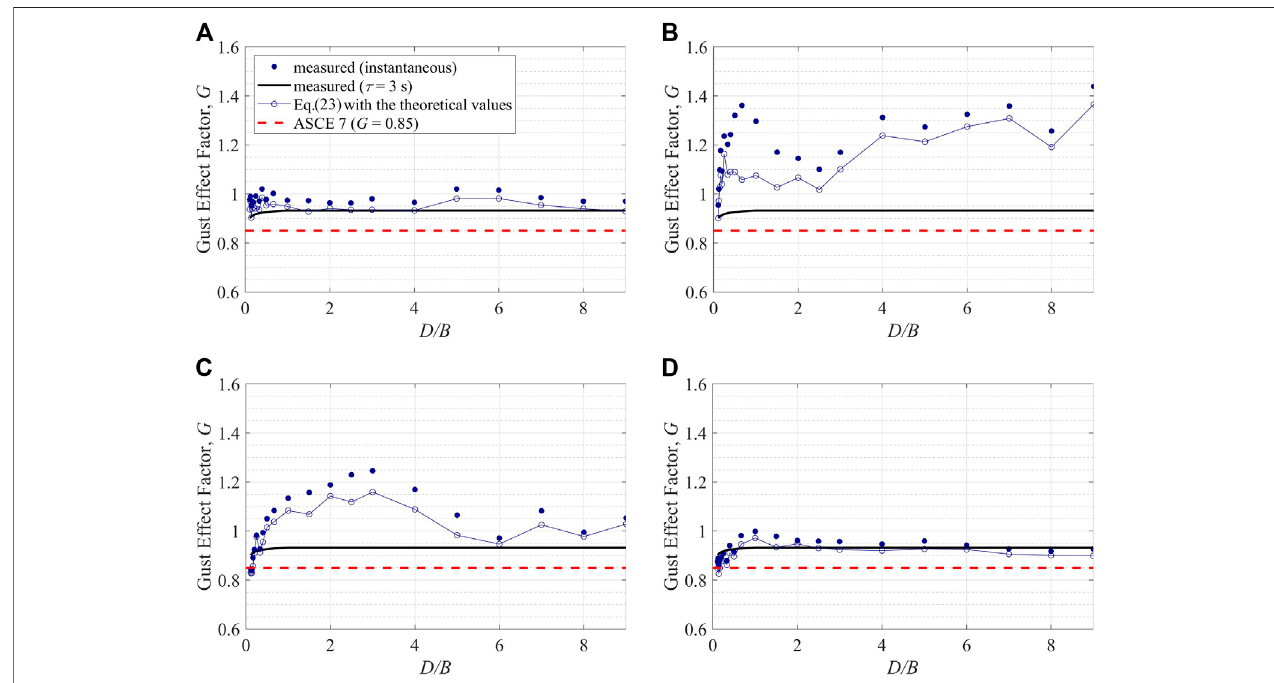
FIGURE 12 | Measured and predicted gust effect factor, G , for area-averaged pressure coef fi cients on the (A) windward wall (B) side wall (C) leeward wall and for (D) base drag coef fi cients under the orthogonal wind direction.